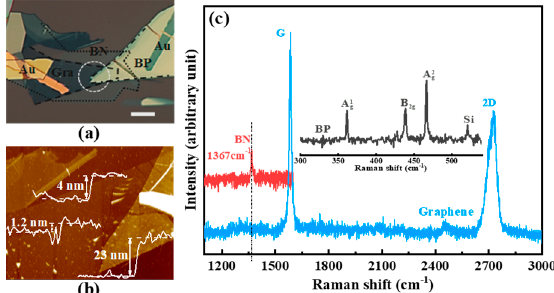
Figure 2. ( a ) An optical microscope image of the black phosphorus (BP) / boron nitride (h-BN) / graphene heterojunction, where the lines indicate different materials: graphene (dashed), h-BN (point), and BP (dot-line). The scale bar is 10 μ m. ( b ) Atomic force microscopy (AFM) images of the heterojunction device. The thickness of BP, h-BN, and graphene is ~23, ~4, and ~1.2 nm, respectively. ( c ) Raman spectra of exfoliated graphene (blue), h-BN (red), and BP (black) film in the device on the SiO 2 substrate.